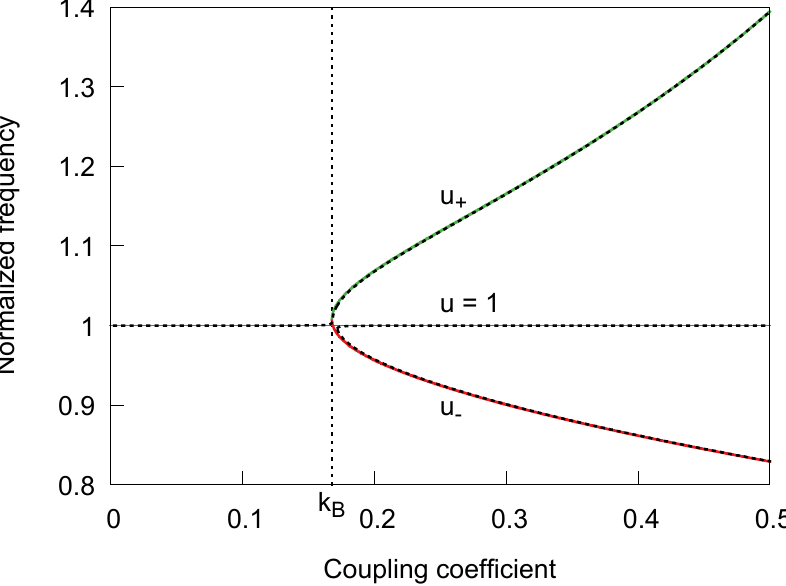
Figure 2. The main resonant frequency u = 1 and the secondary frequencies u ± as function of the coupling coefficient k for the example configuration. Frequency bifurcation occurs for a coupling factor k higher than the bifurcation coupling k B . The solid lines indicate the results for the approximate admittance matrix Y a , the dashed lines for the exact admittance matrix Y